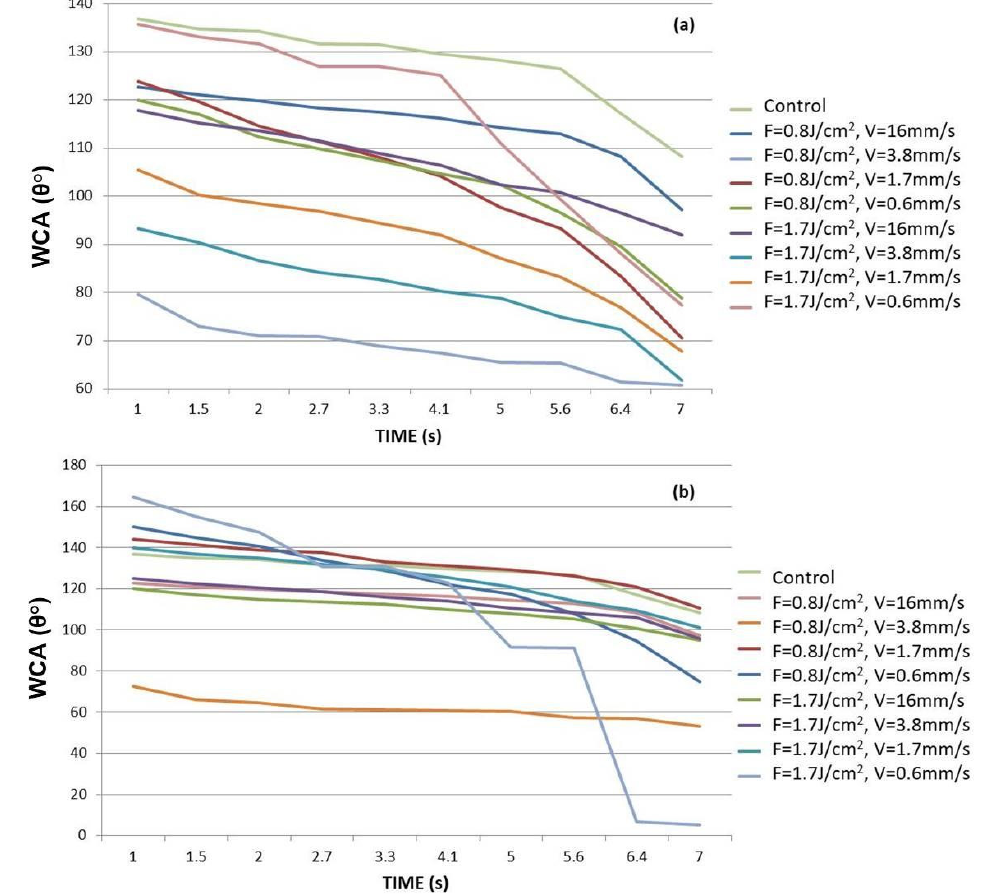
Figure 9. WCA evaluation of Fs modified PLA samples for a period of 7 s—( a ) the dH 2 O drop applied along the direction of the grooves; ( b ) the dH 2 O drop applied perpendicular to the direction of created grooves.